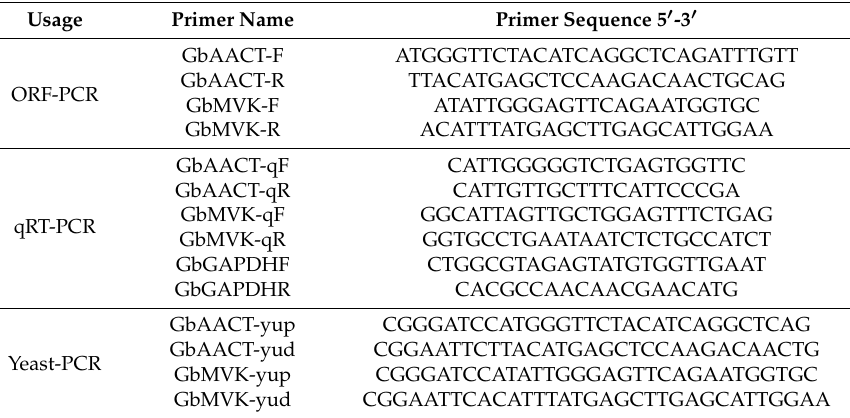
Table 1. Primers used in this study. ORF: open-reading